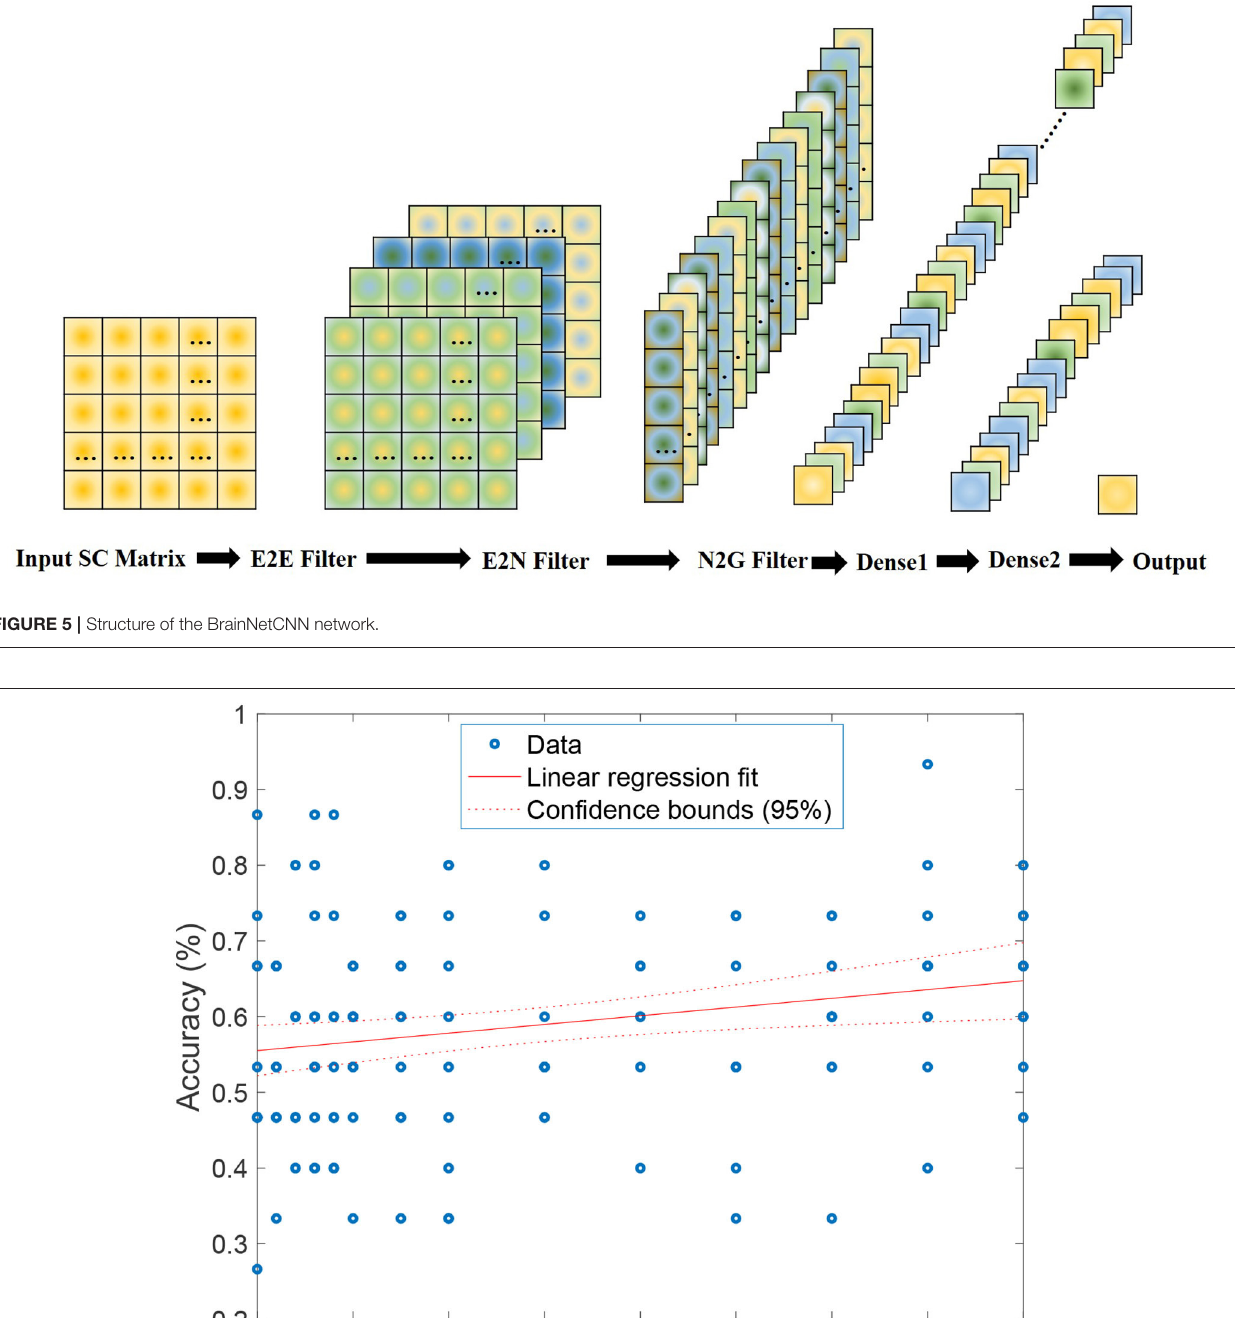
E2N filter and N2G filter are c E 2 N = c 1 , c N 2 G = c 2 . In